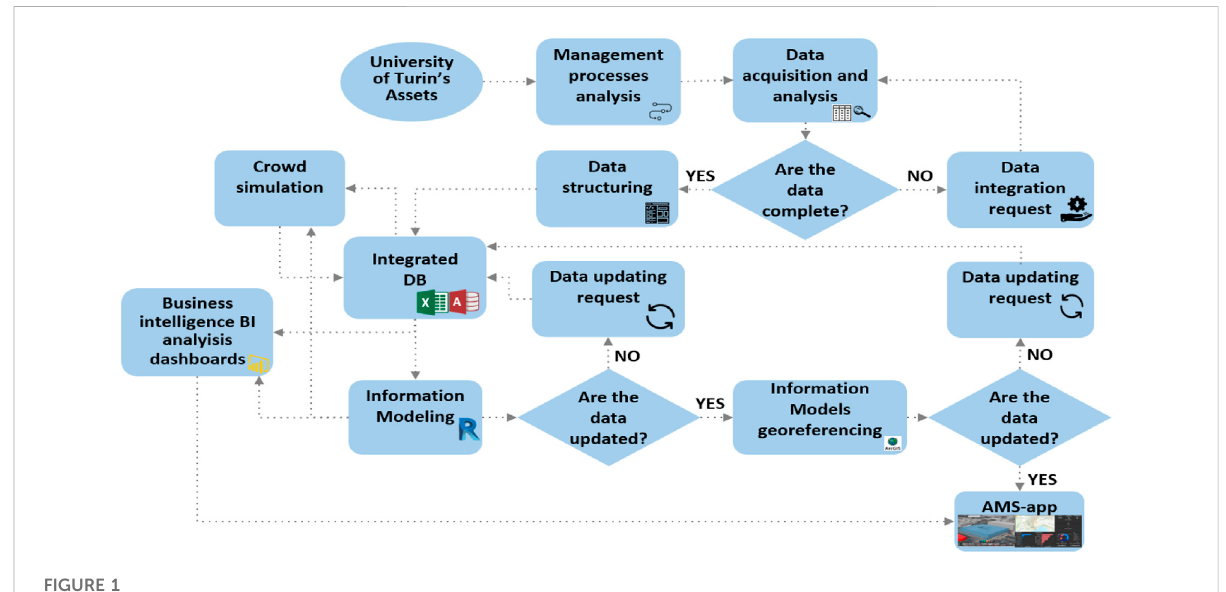
FIGURE 1 Research project methodological